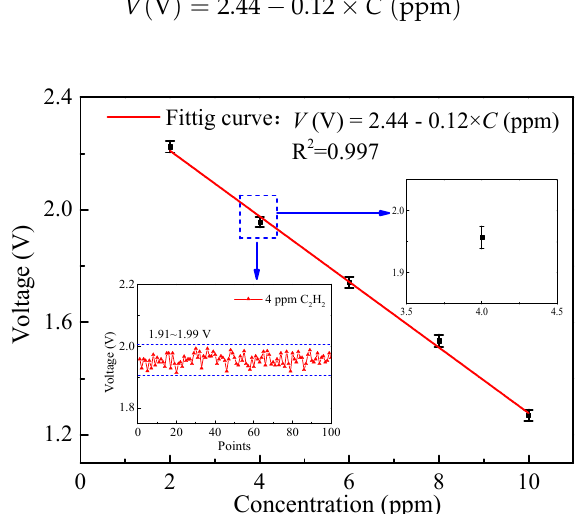
Figure 9. Fitting curve of the cavity-transmitted signal voltage versus C 2 H 2 concentration. The lower inset shows the measurement results of 4 ppm C 2 H 2 , and the upper inset shows the error bar of the results.